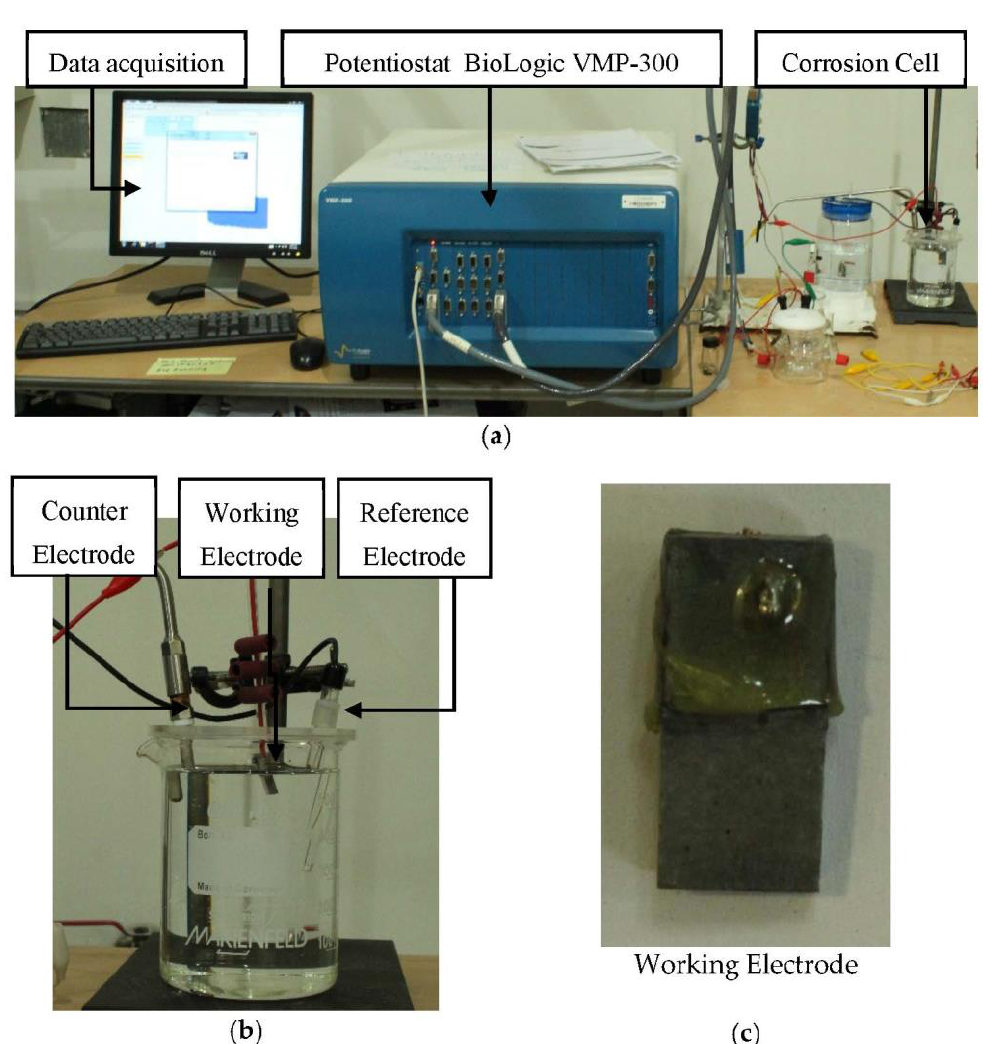
Figure 3. Tensile testing sample ( a ) experimental apparatus, ( b ) corrosion cell, and ( c ) test sample with exposed area of 1 cm 2 .